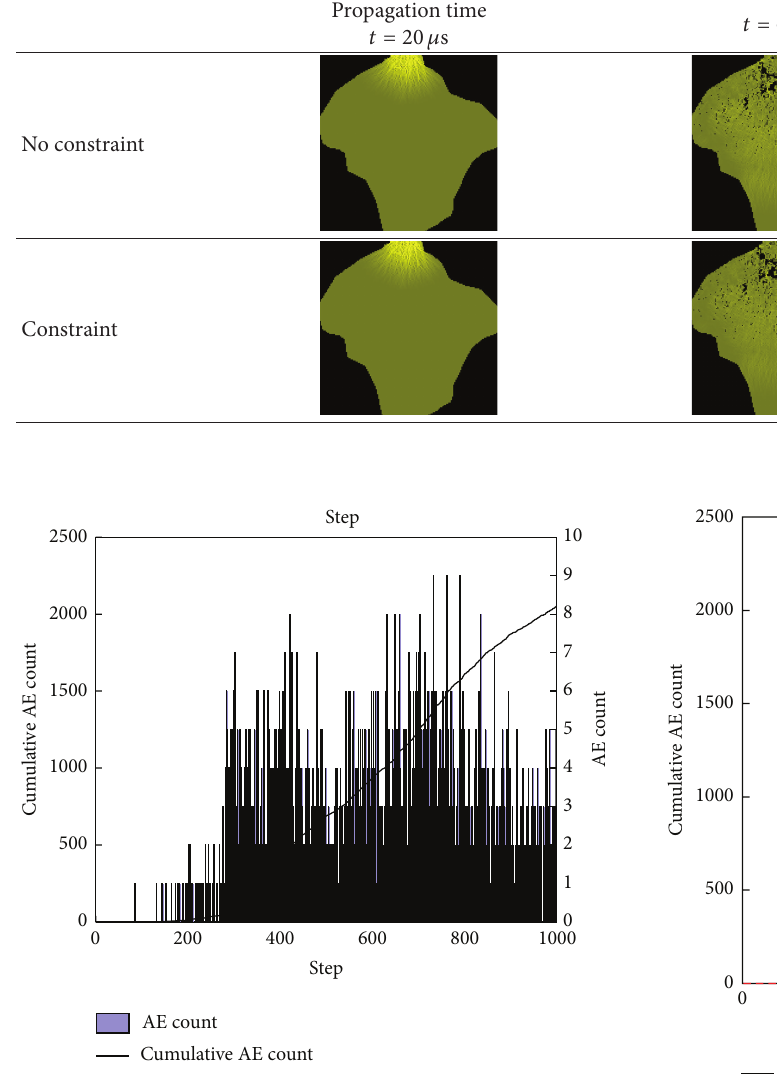
Figure 13: The counts of damaged elements of numerical sample with constraint at different loading step.